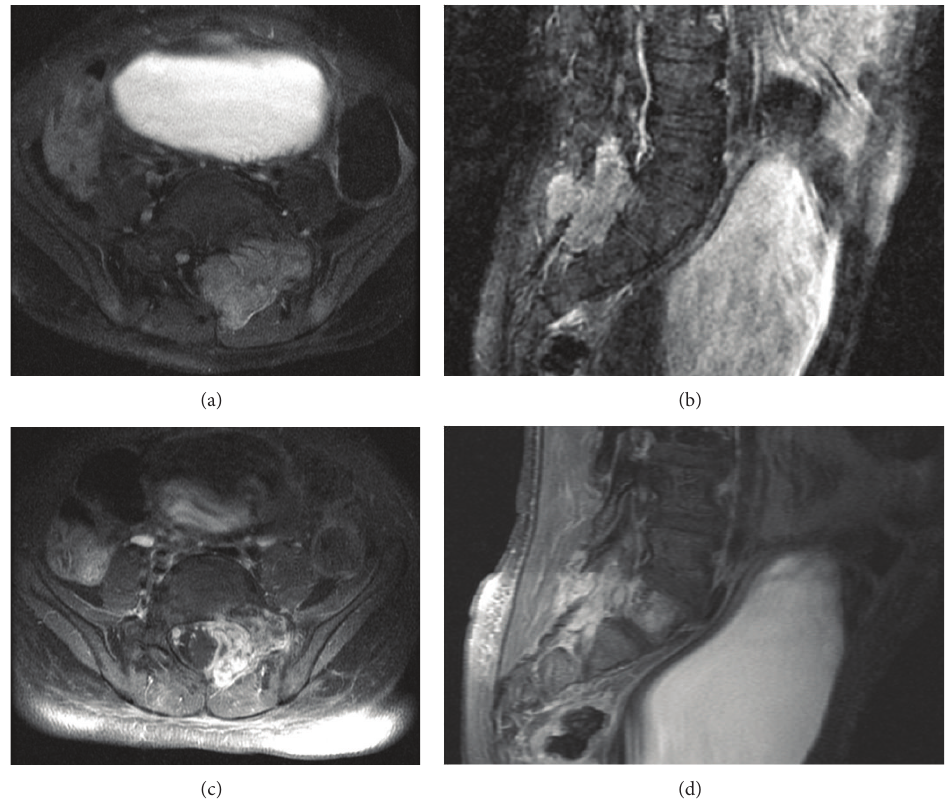
Figure1:Magneticresonanceimagesofasacralosteosarcomametastasisina5-year-oldboy.Axial(aandc)andsagittal(bandd)T1-weighted images acquired with gadolinium before treatment (a and b) and after treatment (c and